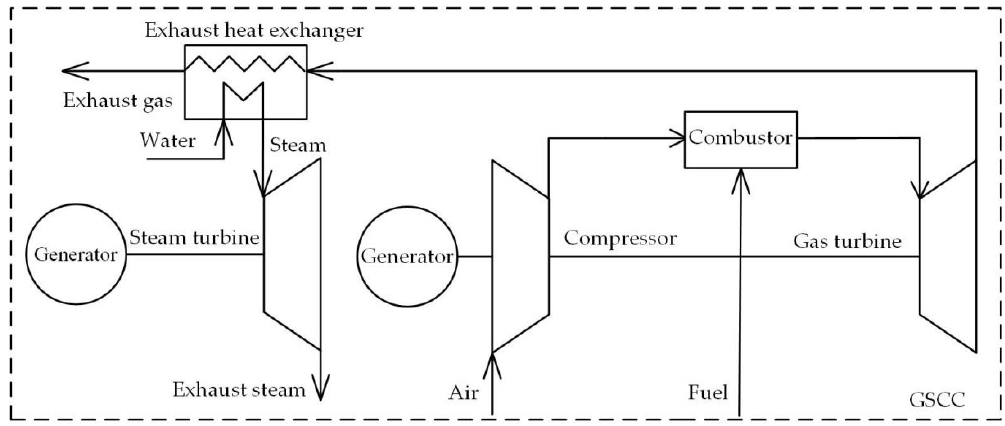
Figure 2. Flow chart of micro gas-steam combined cycle system.